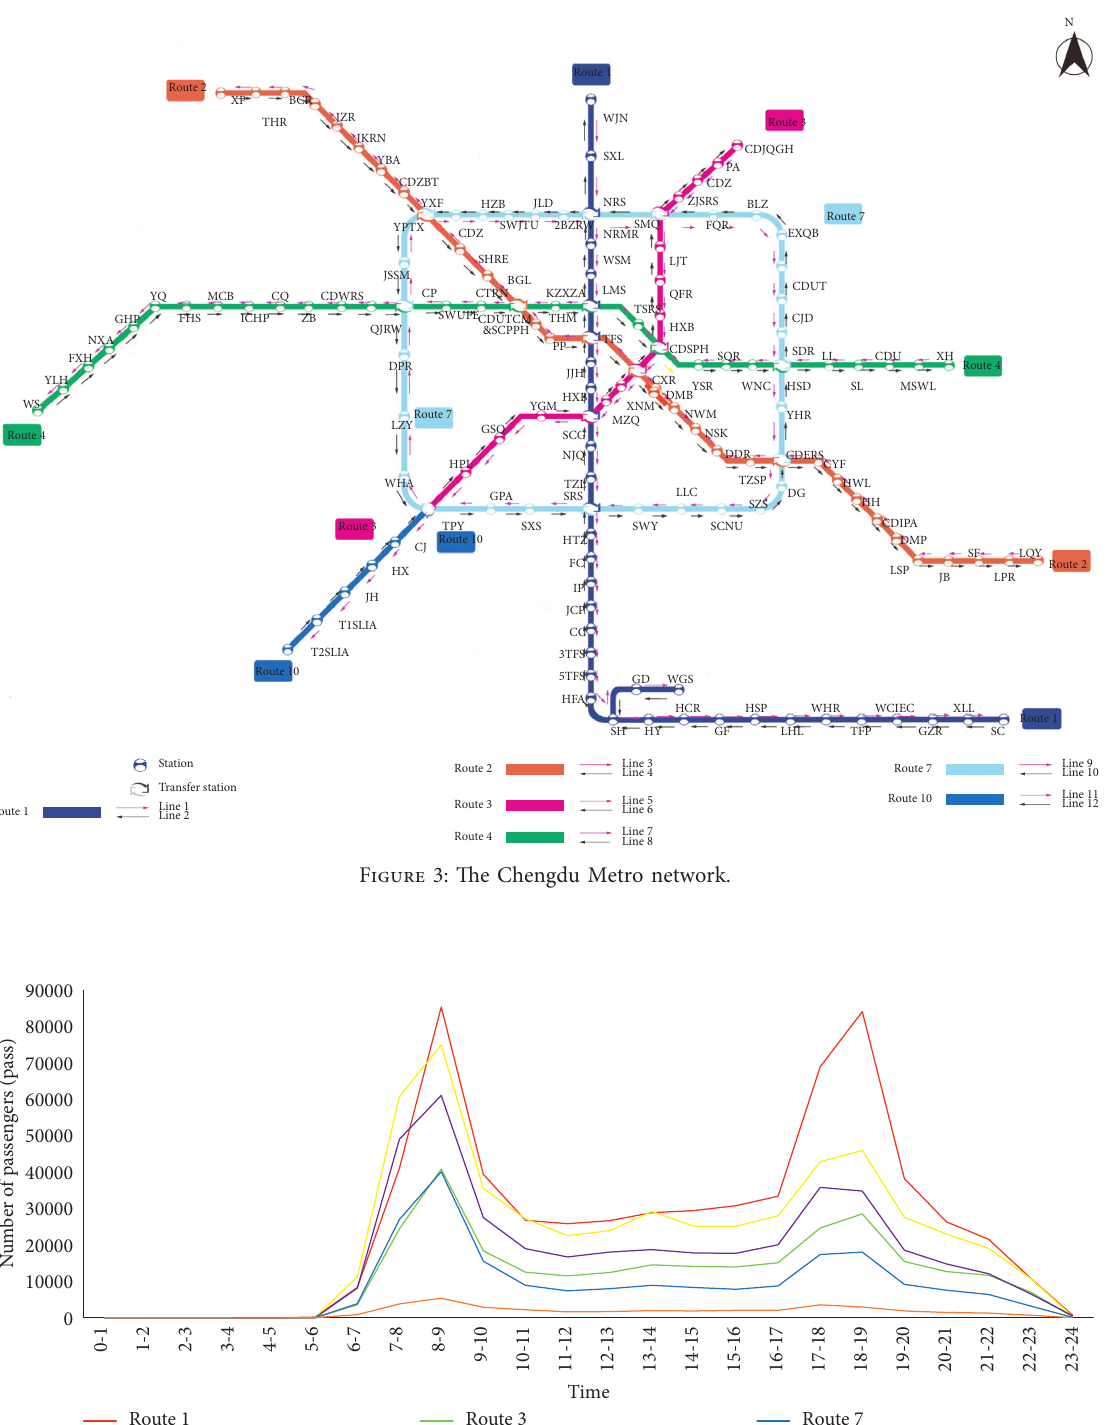
Figure 4: Ridership distribution over time on a typical